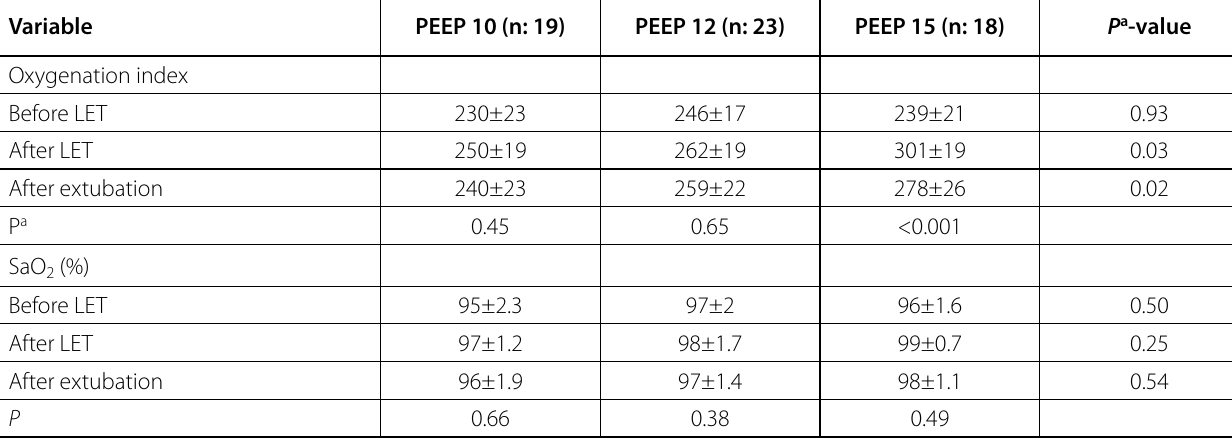
Table 2 . Analysis of oxygenation in different levels of PEEP of patients submitted to